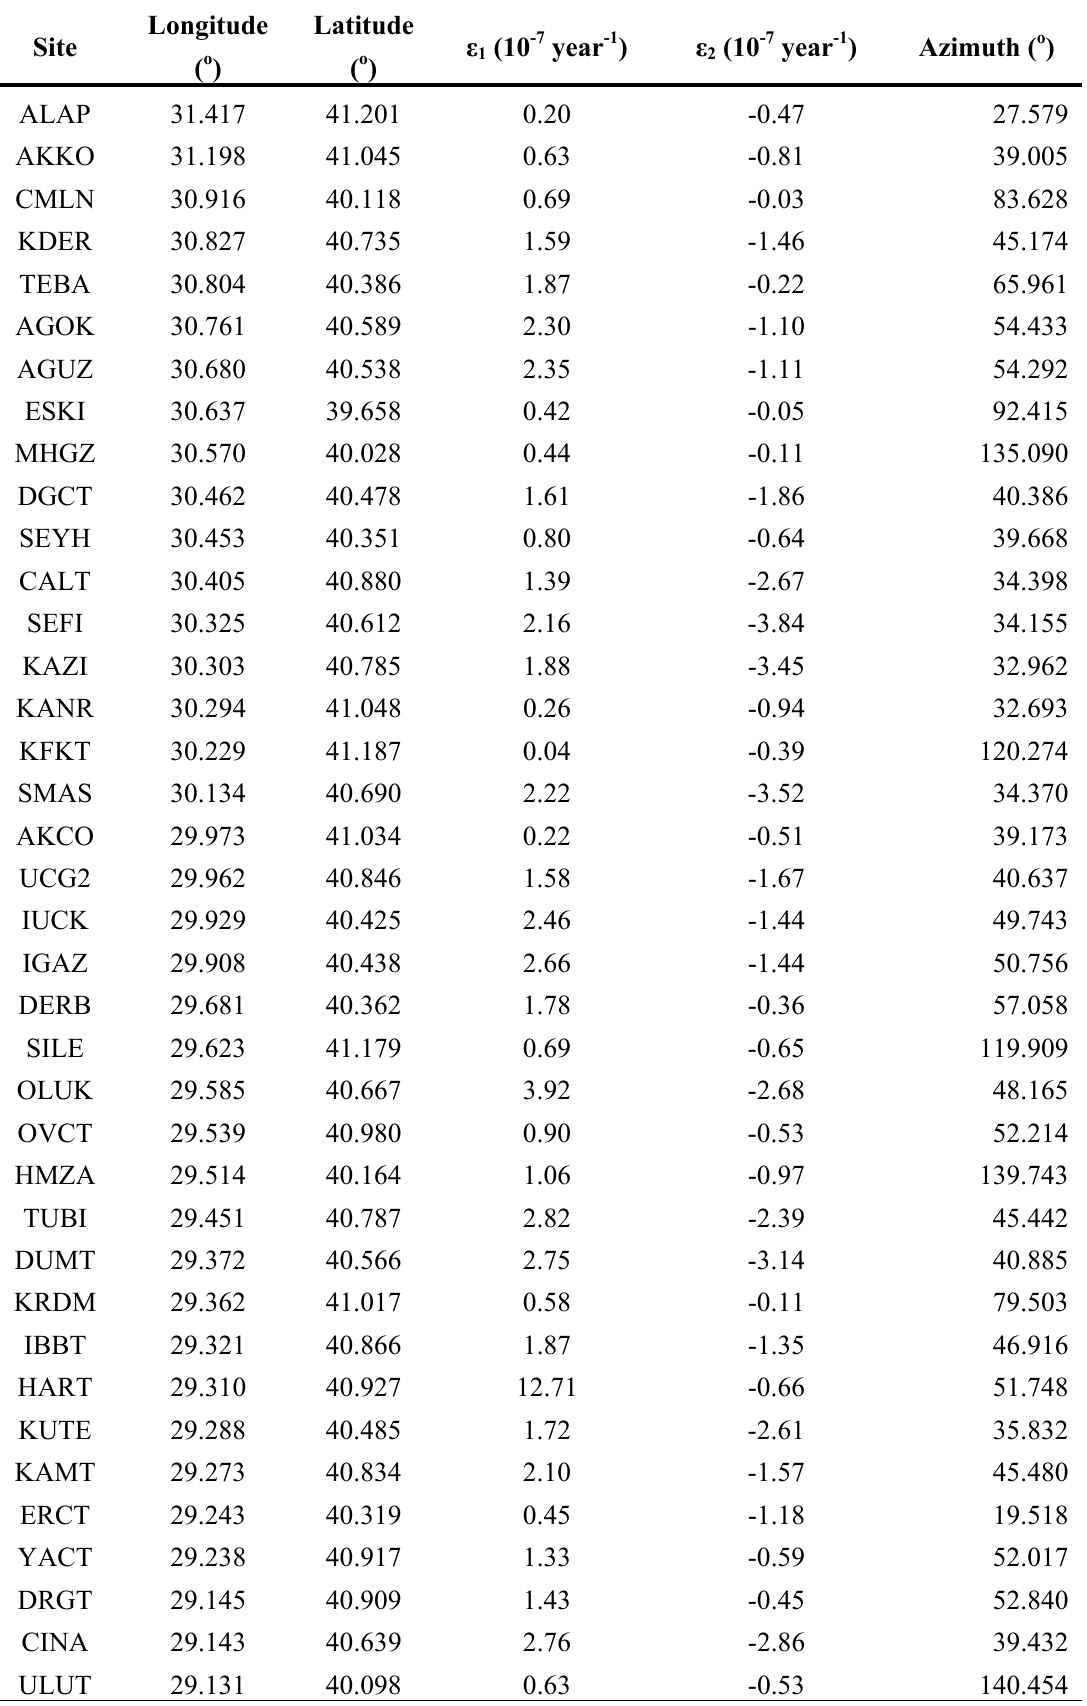
Table 2. Principal strains computed at GPS